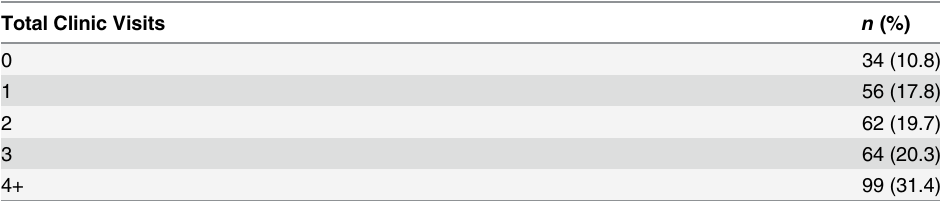
Table 3. Clinic Visit